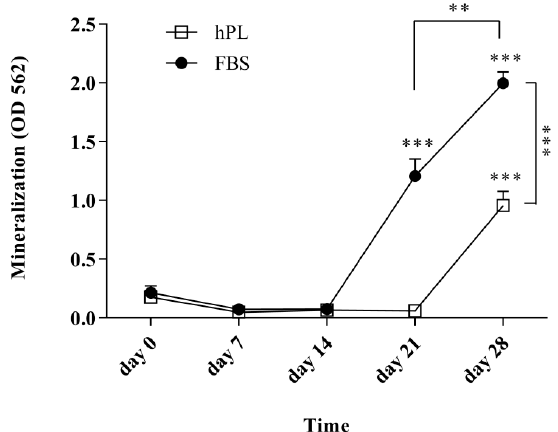
Figure 4. Mineralization during osteogenic differentiation. Significant mineralization was observed after 21 and 28 days for the FBS–hES-MP and hPL–hES-MP cells, respectively. The level of mineralization was significantly higher in the FBS–hES-MP cells than in the hPL–hES-MP cells by the end of 28 days. (** p ≤ 0.01; *** p ≤ 0.001; p -values directly above data points were compared with that data point on day 0.)